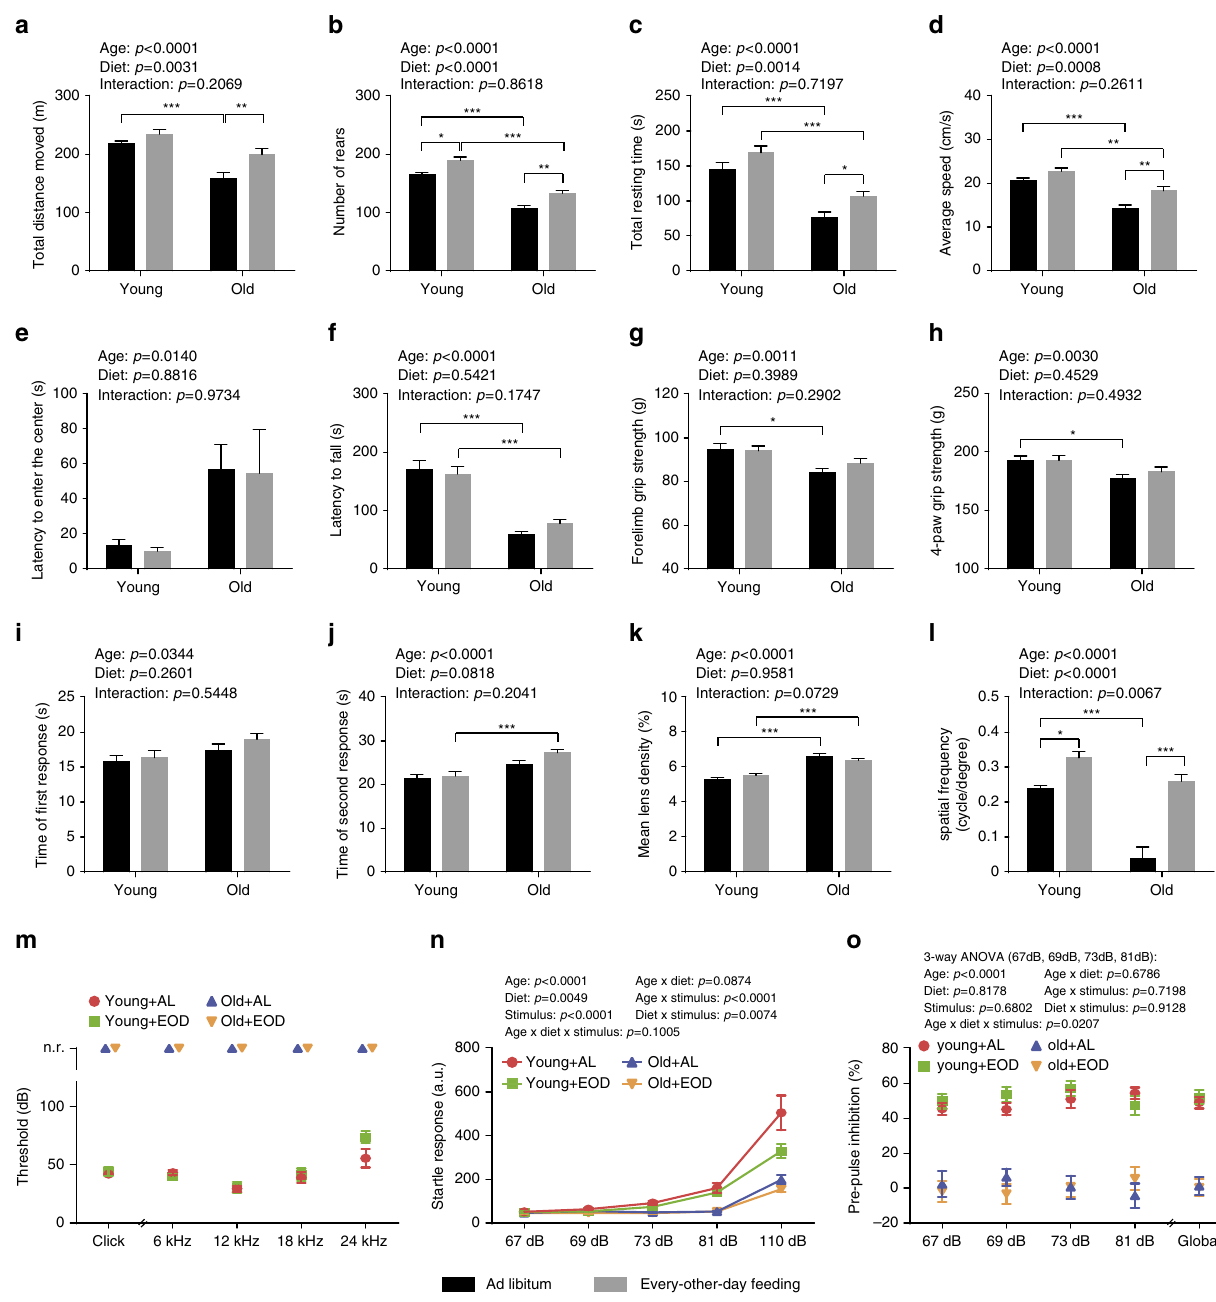
Fig. 2 Neurological and ophthalmological phenotypes. a – j Assessment of neurological and behavioral phenotypes (two-way ANOVA; young + AL: n = 16, young + EOD: n = 16, old + AL: n = 23, old + EOD: n = 23). Analysis of locomotor activity including a total distance moved, b number of rears, c total resting time, d average speed, and e latency to enter the center as determined in an open- fi eld test. f Latencies to fall on an accelerating rotatod. g , h Muscle strength measured by two-paw (forelimb) and four-paw grip strength tests. i , j Latencies to fi rst and second reaction in a hot-plate-based assessment of nociceptive function. k Quanti fi cation of mean lens density by Scheimp fl ug imaging (two-way ANOVA; young + AL: n = 7, young + EOD: n = 8, old + AL: n = 7, old + EOD: n = 6). l Assessment of visual acuity using the virtual drum test (two-way ANOVA; young + AL: n = 7, young + EOD: n = 8, old + AL: n = 7, old + EOD: n = 6). Analysis of m auditory brain stem responses (young + AL: n = 12, young + EOD: n = 12, old + AL: n = 10, old + EOD: n = 10), n acoustic startle response and o pre-pulse inhibition (PPI). Statistical analyses for n and o were performed using a three-way ANOVA with the between-subjects factors age (young vs. old), DR (AL vs. EOD), and the within-subjects factor sound intensity (Greenhouse-Geisser correction) (young + AL: n = 16, young + EOD: n = 16, old + AL: n = 23, old + EOD: n = 23). AL ad libitum, EOD every-other-day feeding, a.u . arbitrary unit, n.r . no response. Data are shown as mean ± SEM. Full data sets of the open- fi eld test and Scheimp fl ug imaging are presented in Supplementary Tables 7 and